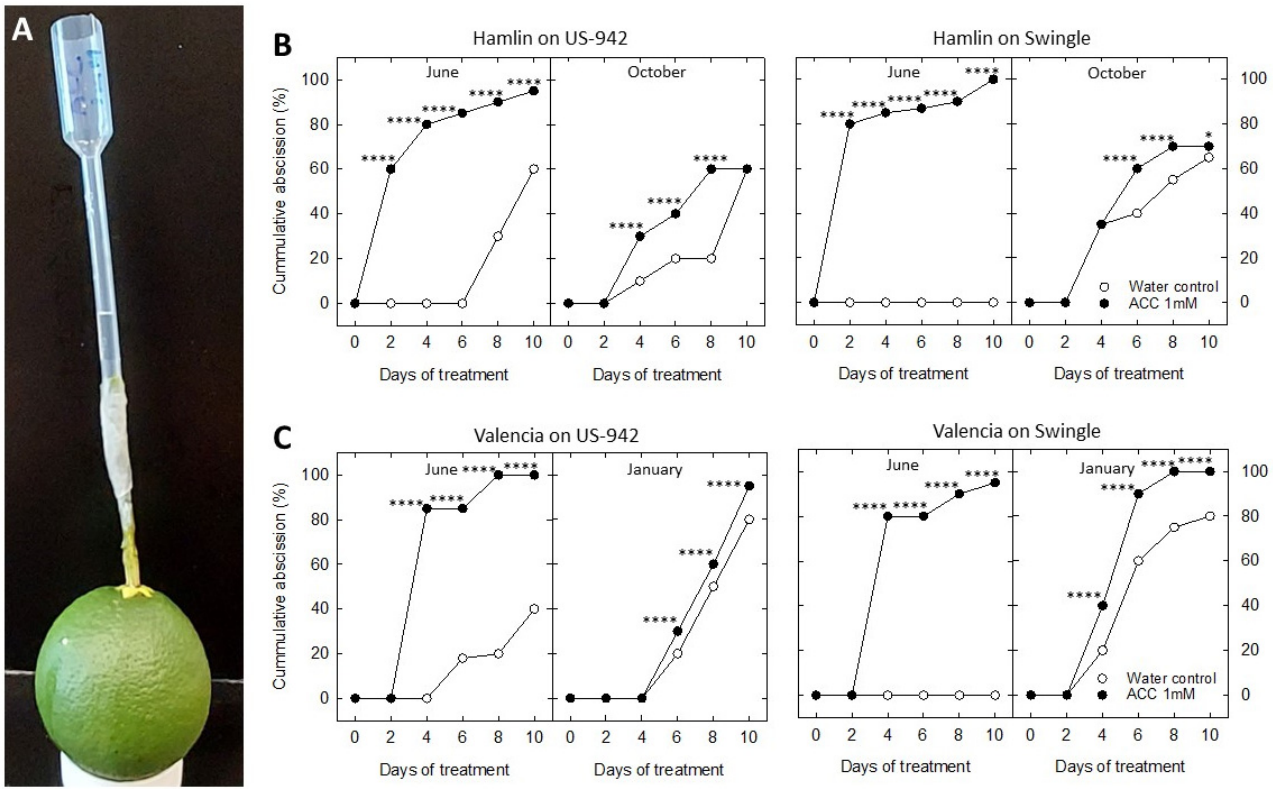
Figure 3. In vitro assessment of fruit explant abscission in fruits from Valencia and Hamlin scions grafted on Swingle and US-942 rootstocks. ( A ), experimental set up, showing a fruit explant with a 5-cm stem and a disposable Pasteur pipette containing the solution treatment. ( B ) and ( C ), abscission in Hamlin and Valencia fruit in both rootstocks at two different stages of maturation. Asterisks *, and **** indicate p -values significant at 5%, and less than 0.01% according to Tukey-Kramer.